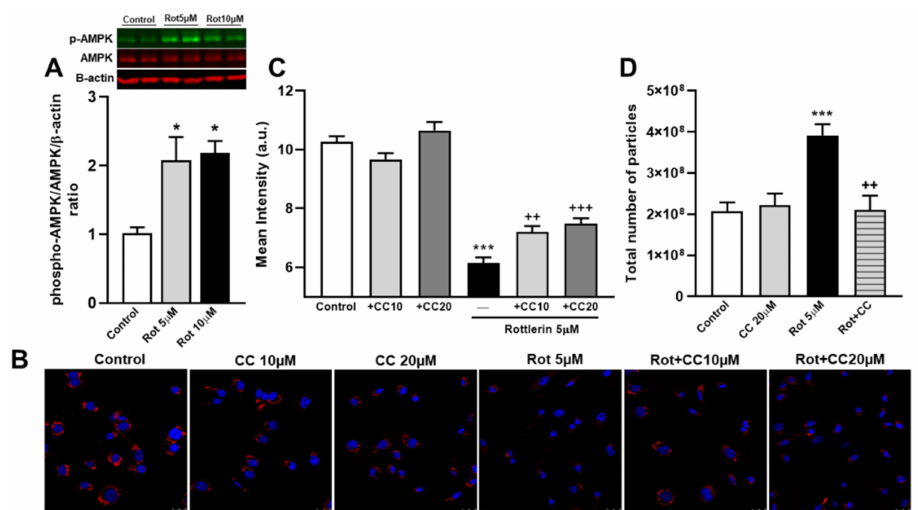
Figure 6. Rottlerin stimulates exosome/microvesicle release via activation of the AMPK (AMP- activated protein kinase) pathway. ( A ) Western blotting and densitometric analyses of whole-cell lysates using anti-phospho-AMPK (T172), AMPK (total), and β -actin antibodies in C6 cells exposed to LDL (20 µ g/mL of cholesterol) and 2.5 µ M U18666A for a total of 16 h without (Control) or with rottlerin (5 µ M and 10 µ M, Rot) for the last 4 h. Results are the mean ± SEM of three indepen- dent experiments. Representative immunoblots are shown. ( B ) C6 cells were exposed to DiI-LDL (20 µ g/mL of cholesterol) and U18666A for a total of 16 h without (Control) or with rottlerin in combination with or without compound C (10 µ M or 20 µ M, CC) for the last 4 h. The cells were then washed, fixed, and analyzed by confocal microscopy. Images show DiI-LDL in red and nuclei labeled with Hoechst-33342 in blue. Representative results from three independent experiments are shown. Scale bars = 25 µ m. ( C ) The graph shows quantitative results of DiI-LDL labelling (mean intensity, a.u.) in cells of each photomicrograph. Results are the mean ± SEM of three indepen- dent experiments, with 8 − 10 photographs per experiment. ( D ) Total particle secretion analyzed by nanoparticle tracking. The experiments started with the same number of cells. Cells were exposed to LDL (60 µ g/mL of cholesterol) in the presence of 2.5 µ M U18666A for 12 h. Then, the medium was removed, cells were washed twice, and serum-free medium was added, supplemented with U18666A, and incubation was continued for 4 h with or without 5 µ M rottlerin (Rot) in combination with or without 20 µ M compound C (CC). At the end of the incubation, the medium was removed, and the exosomes/microvesicles were isolated and analyzed. The graphs represent the total number of particles per experiment analyzed by nanoparticle tracking. Means ± SEM of three measures. Statistical comparisons shown are rottlerin versus control (* p < 0.05, *** p < 0.001) or compound C plus rottlerin versus rottlerin alone ( ++ p < 0.01 and +++ p <